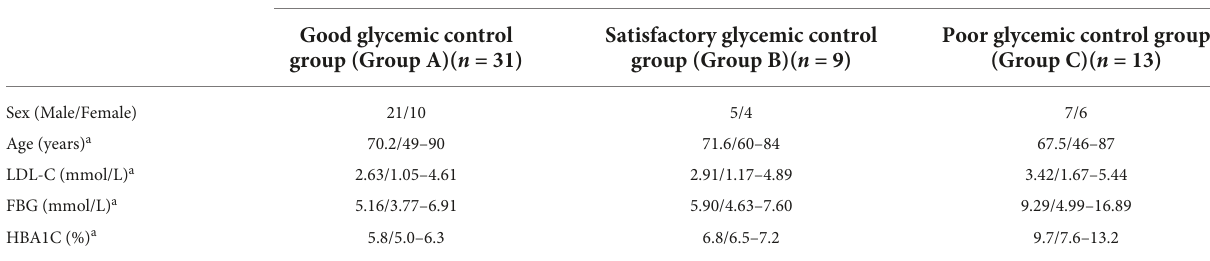
TABLE 1 Clinical characteristics of 53 stroke patients.